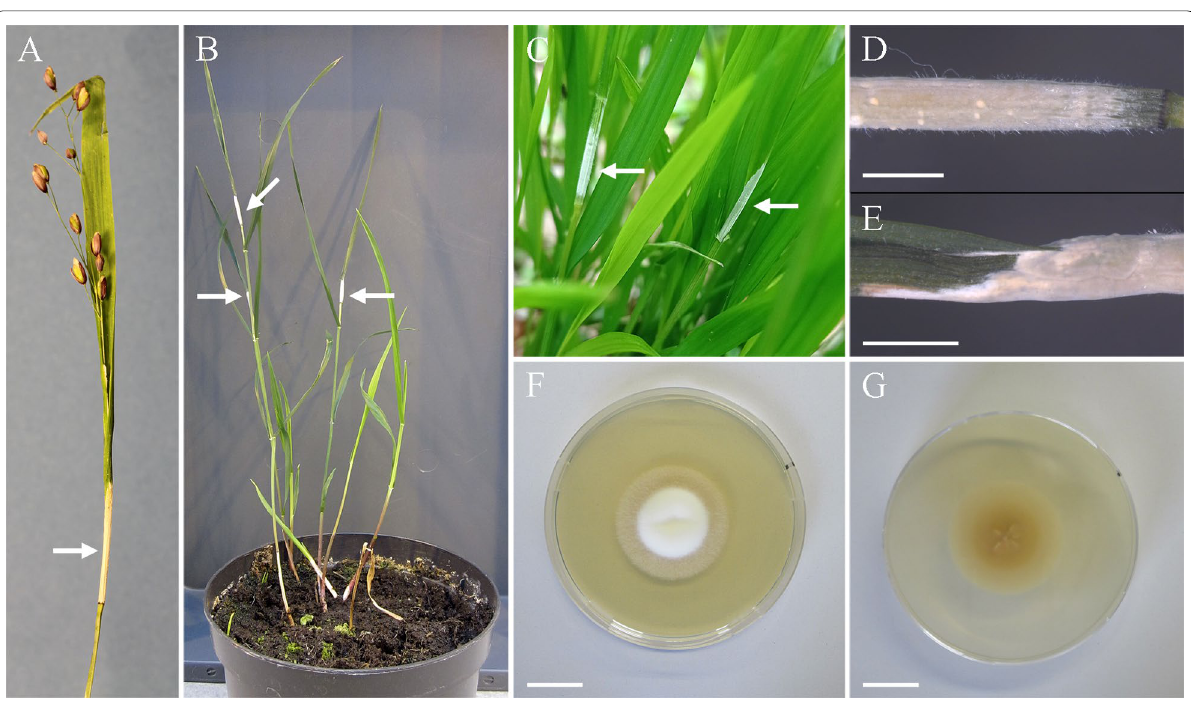
Fig. 2 Stromata on Melica uniflora (indicated by arrows) and growth in culture media. a Partial choking on a stroma bearing specimen of M. uniflora collected at sample site A. b Daughter ramets with stromata of the specimen collected at sample site A grown in the greenhouse. c Stromata on M. uniflora at sample site E. d , e Close-up images of a stroma on a daughter ramet grown in the greenhouse. Scale bars: 3 mm. f , g Isolate growing on PDA, top view ( f ) and bottom view ( g ). Bars 2 =